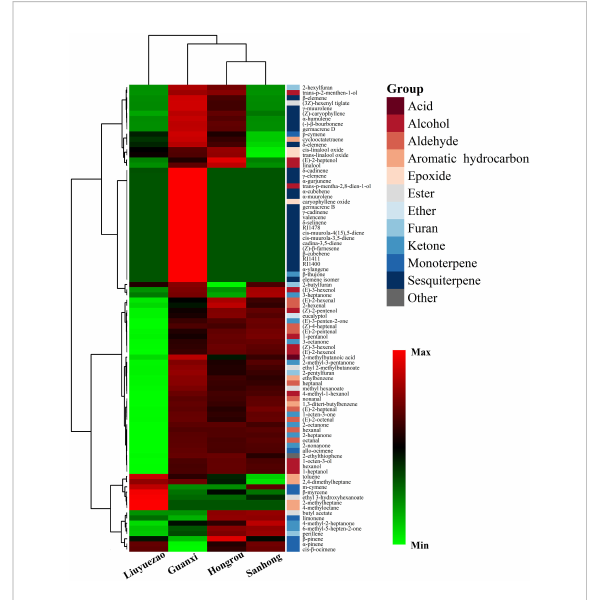
FIGURE 5 HCA of volatile pro fi les in pulp samples from the four pummelo